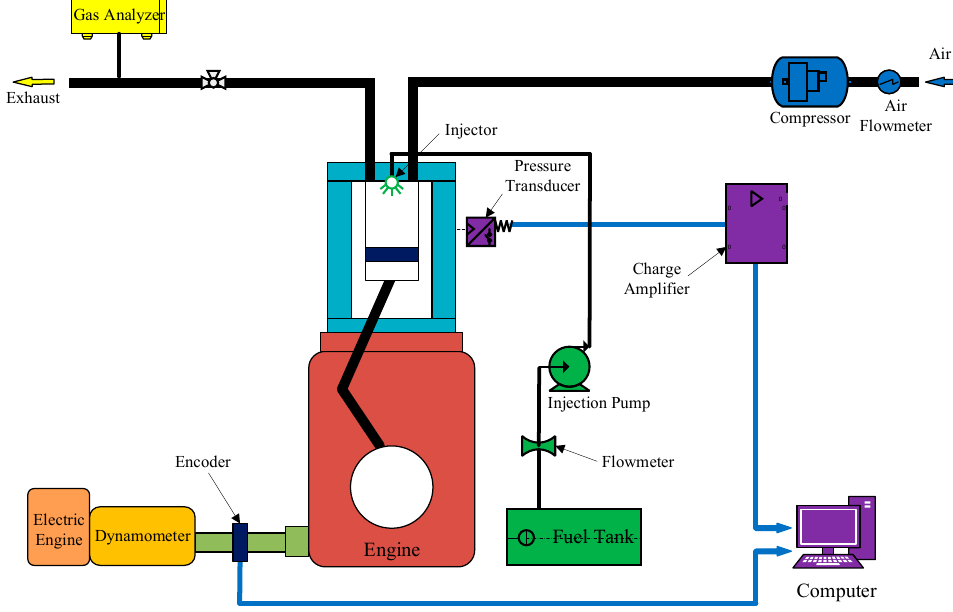
Figure 2. Schematic diagram of the experimental setup used in the present study. Three binary SFO fuel samples along with reference diesel were tested in this engine. The tests were performed at 100% load and different engine speeds ranging from 1200 to 2400 rpm, at a 200 rpm interval. Each data collection was replicated three times and the average data were taken to prevent potential errors. Shortly after each experi- ment was completed, the engine was rinsed with pure diesel.